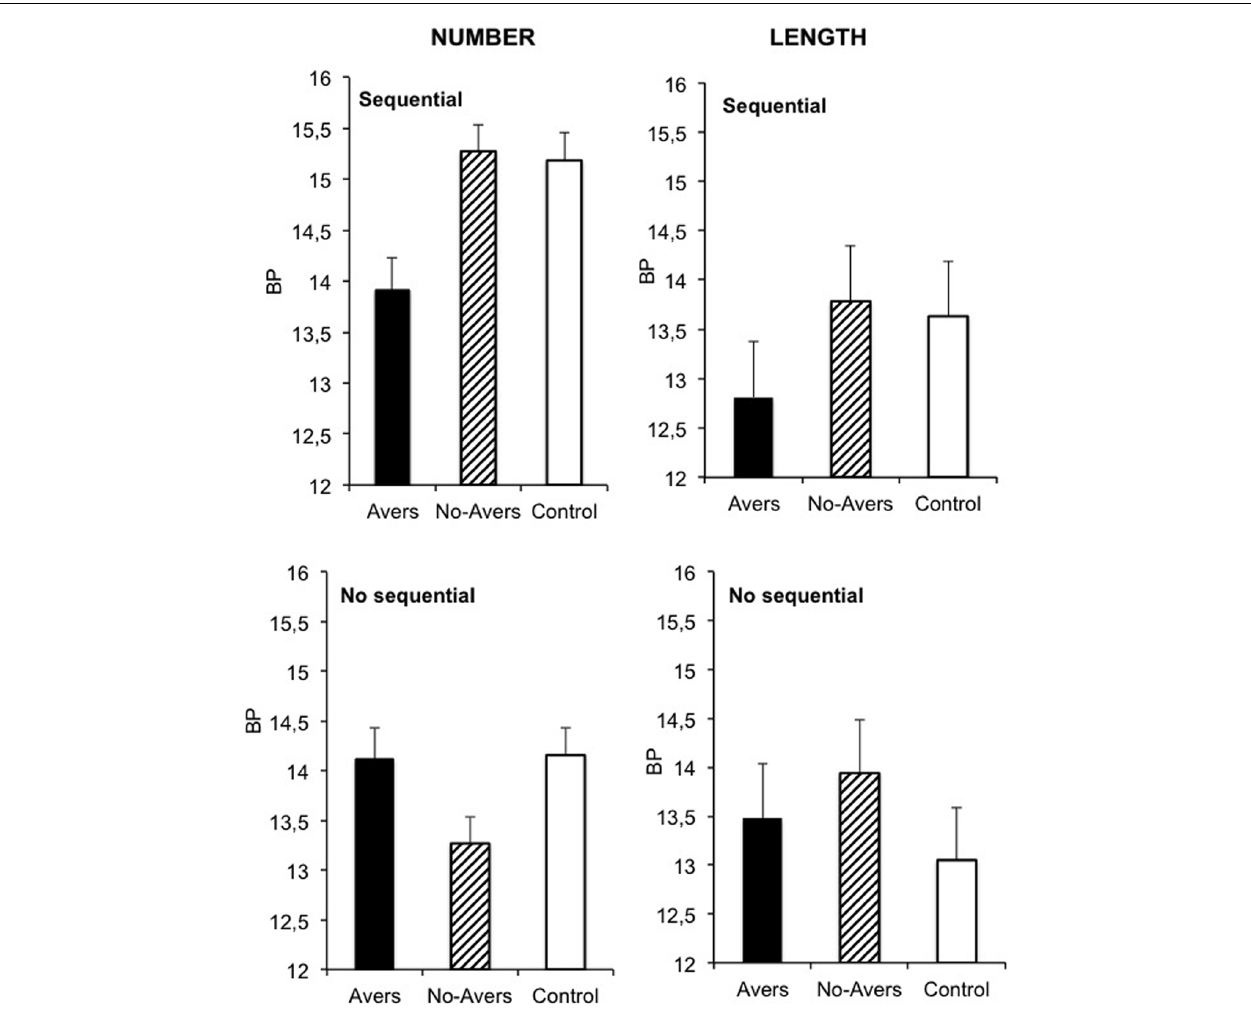
FIGURE 1 | Mean bisection point for the number and length bisection in the aversive, the non-aversive and the control condition for the sequential and the non-sequential stimulus presentation.